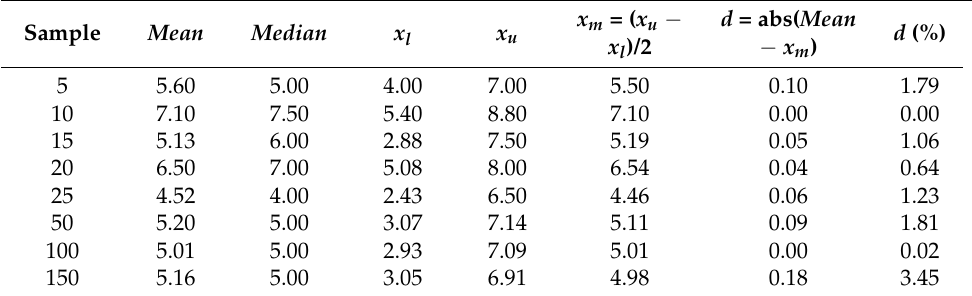
Table 1. Difference between the mean value of the sequence of numbers and the value obtained by the proposed approach.